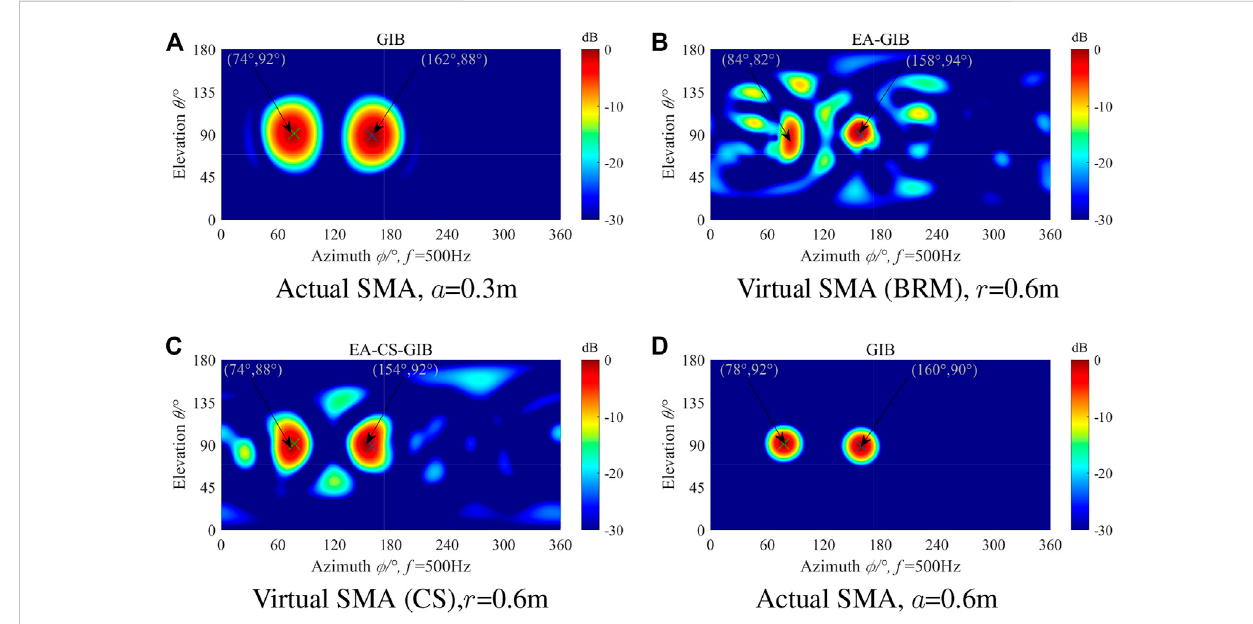
FIGURE 10 The simulation results for double sources localization andidenti fi cation usingthe virtual SMAin (B) and (C) at500 Hzand SNR =20dB, and usingthe actual SMA shown in (A) and (D) for comparison purposes.